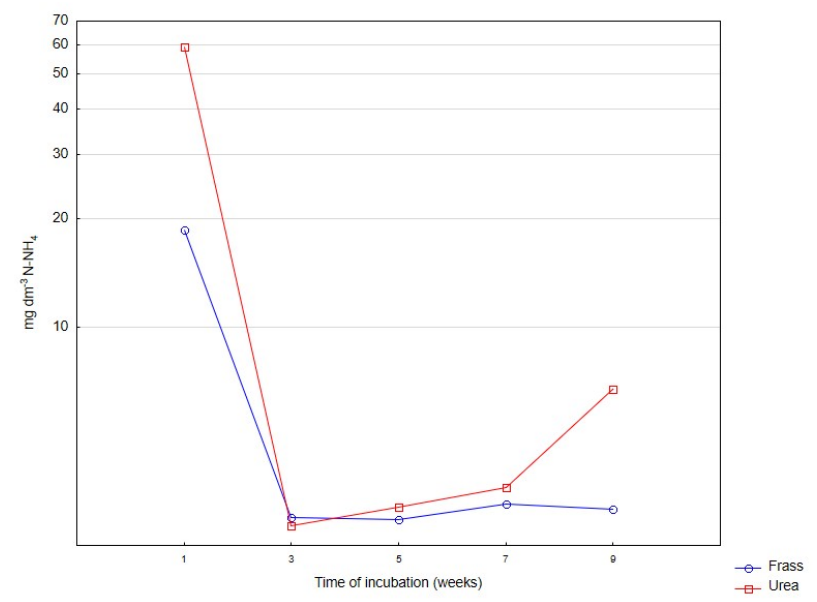
Figure 1. Changes in the content of N-NH 4 in deacidified peat incubated with frass and urea. Differences are presented on a logarithmic scale.